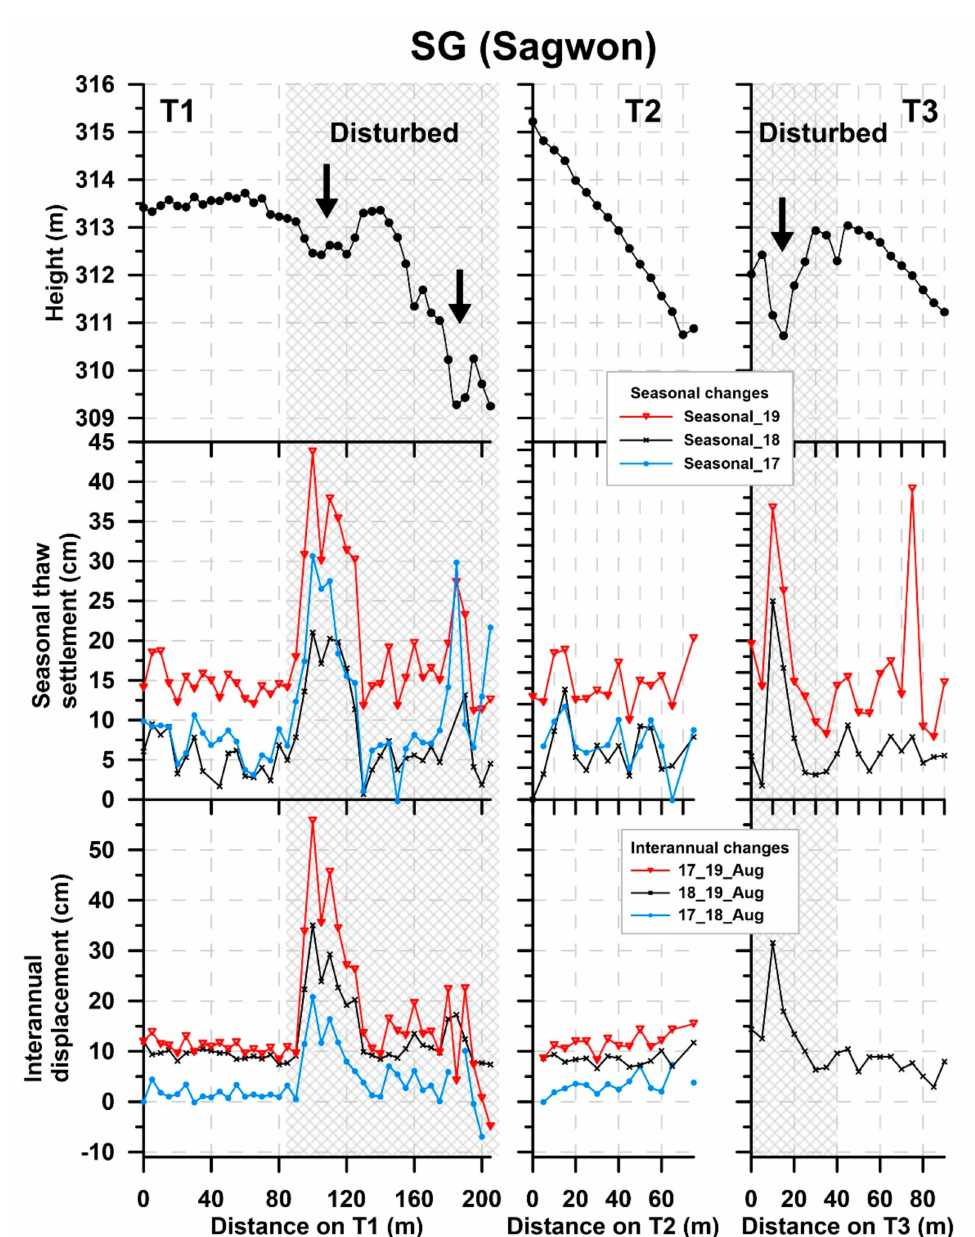
Figure 5. Microtopography in ellipsoid height (top), seasonal thaw settlement (middle), and interannual displacement at site SG. The disturbed portions in transects T1 and T3 are highlighted in the hachured pattern. The heights of the ground surface at survey stakes were measured on 30 May and 19 August in 2017, 4 June and 11 September in 2018, and 29 May and 25 August in 2019. The arrows indicate locations of thermokarst depressions. Seasonal thaw settlements measured between spring and fall survey days are shown as Seasonal_17, Seasonal_18, and Seasonal_19 for thaw seasons in 2017, 2018, and 2019, respectively (middle). Interannual surface displacements for the period between fall survey days are displayed as 17_18_Fall, 18_19_Fall, and 17_19_Fall, for the 1 year displacement from 2017 to 2018, 1 year displacement from 2018 to 2019, and 2 year displacement from 2017 to 2019,